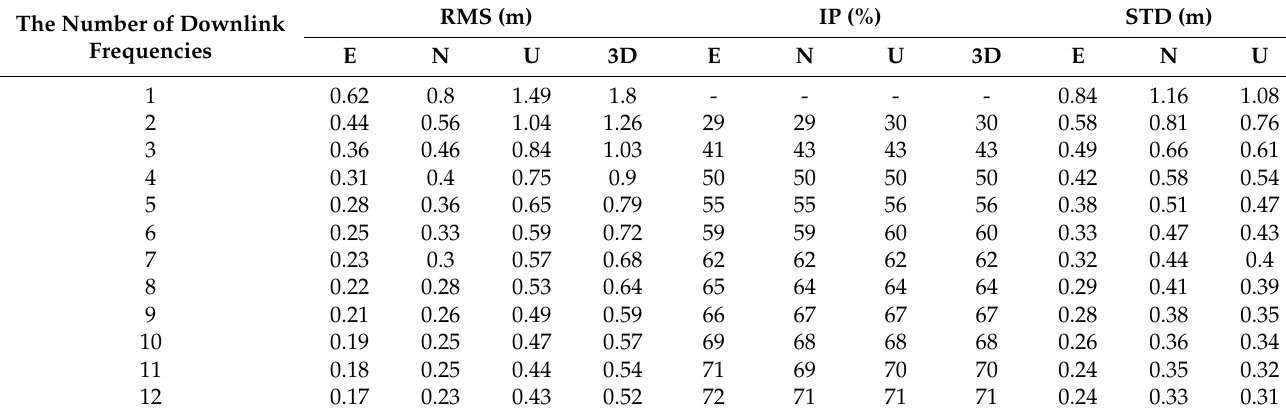
Table 4. Statistical results of the GNSS